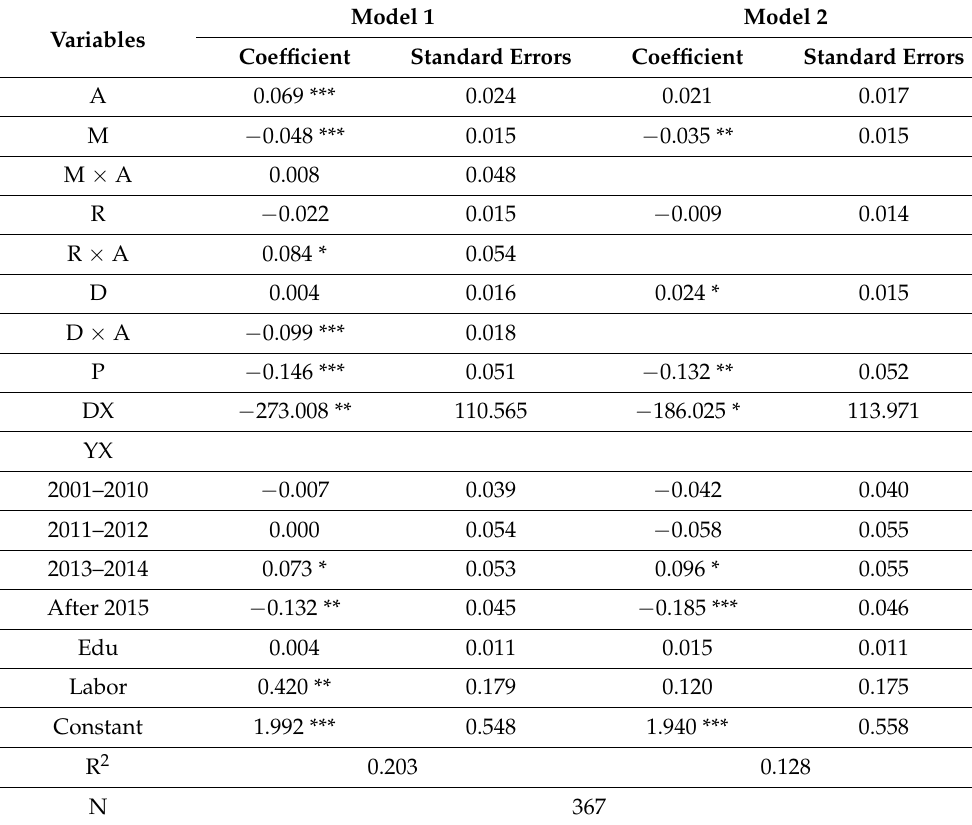
Table 2. OLS regression of occupancy